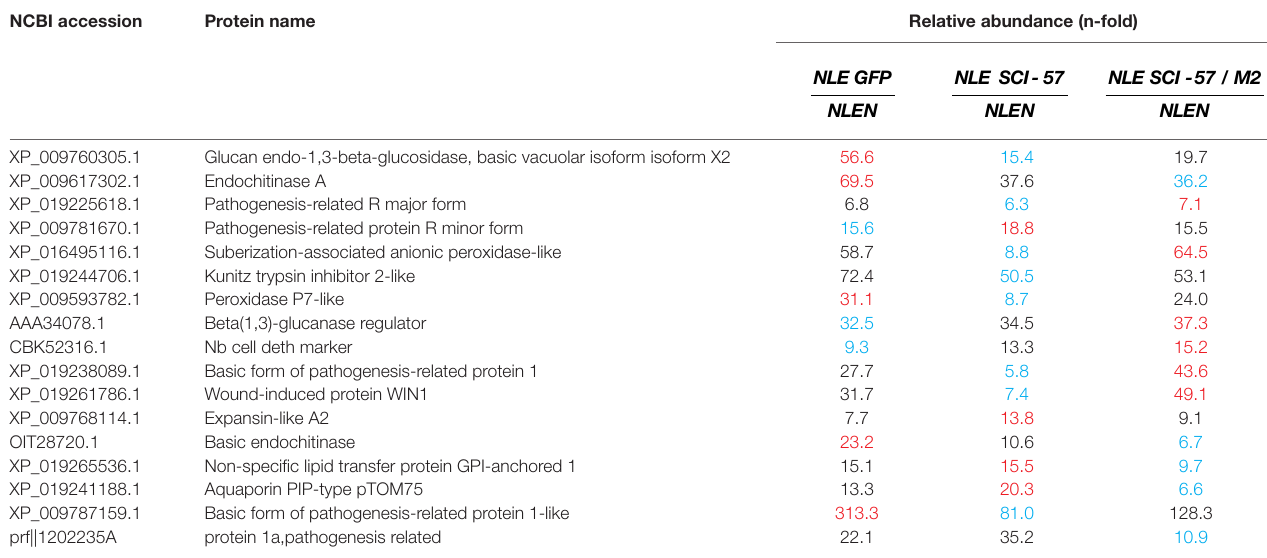
TABLE 1 | Relative abundance of up-regulated proteins 1 by at least 5-fold in NLE GFP, NLE SCI-57 and NLE SCI-57/M2 compared with NLEN. nCBI accession